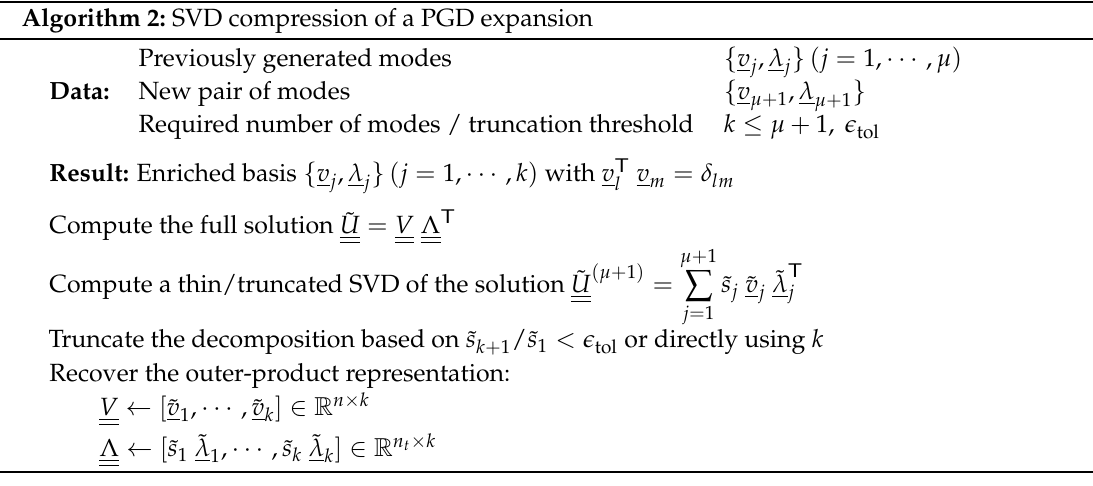
Algorithm 2: SVD compression of a PGD